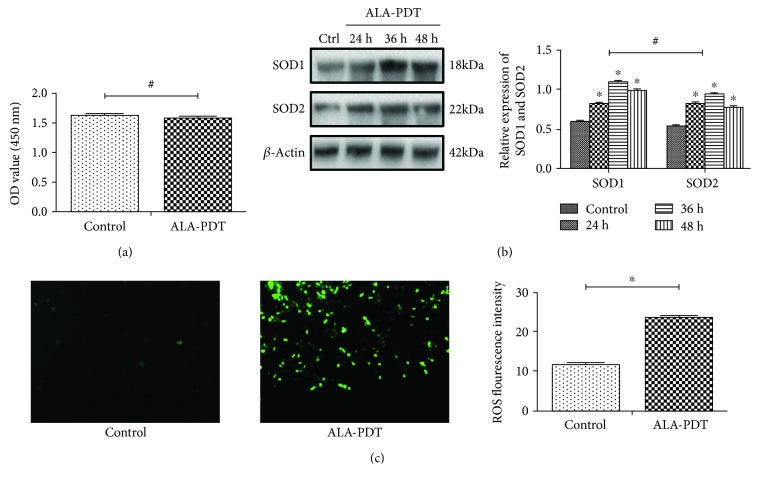
Sublethal doses of ALA-PDT induced intracellular ROS, and the expression levels of SOD1 and SOD2 were determined in HaCaT cells. The ALA-PDT group was treated with the following components: 0.5 mmol/L of ALA and 3 J/cm2 of red laser light. (a) Cell viability was detected by the CCK-8 assay at 450 nm after being treated with a sublethal dose of ALA-PDT. (b) The expression levels of SOD1 and SOD2 proteins were determined 24 h, 36 h, and 48 h after receiving a sublethal dose of ALA-PDT. Protein expression levels were quantified by using β-actin as a control. (c) Cells in the ALA-PDT group were treated with a sublethal dose of ALA-PDT. The intracellular ROS showed green fluorescence under a fluorescence microscope, and the fluorescence intensity was determined by a fluorescence microplate reader. Data were expressed as mean ± SD, n = 3 for each group, ∗p < 0.05, #p > 0.05.